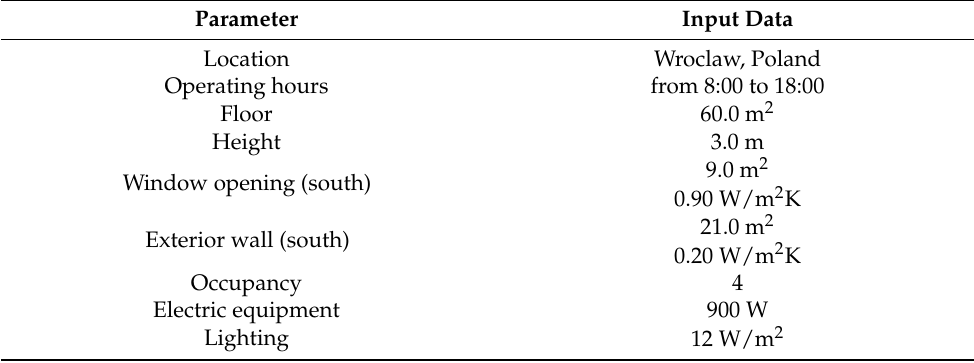
Table 3. The characteristics of the office room which is considered as the case